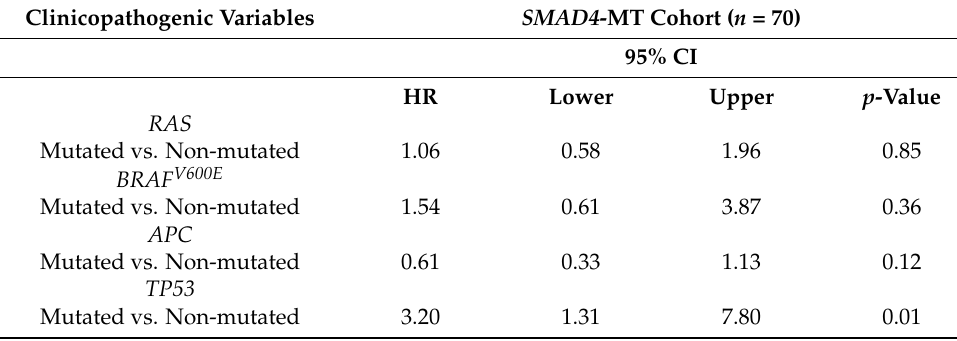
Table 3. Multivariate survival model analysis for OS in patients with SMAD4 mutation.